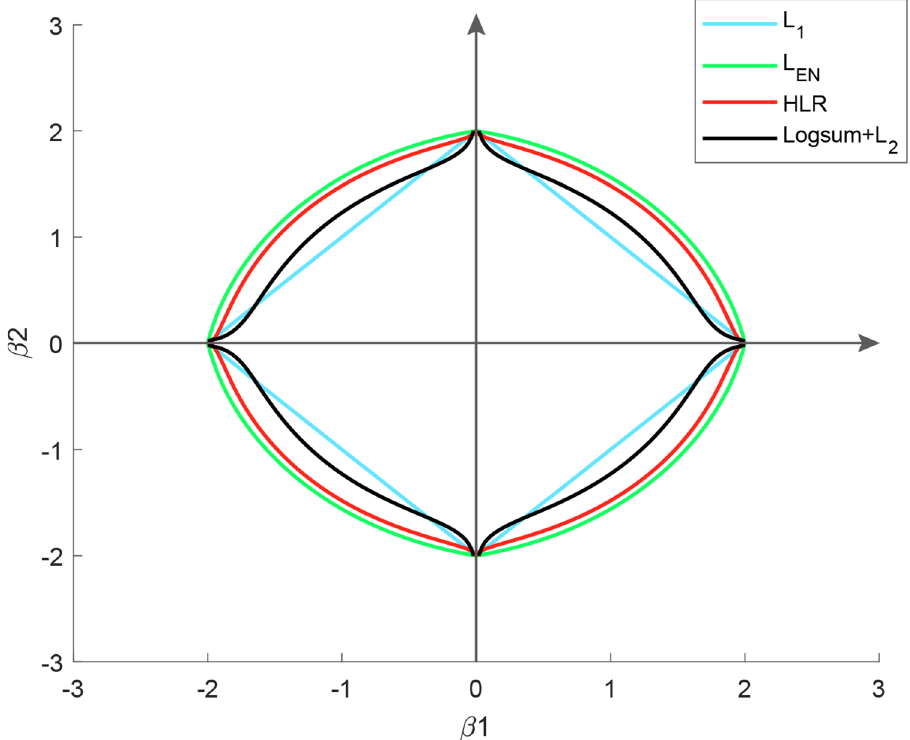
Figure 1. Contour plots (two-dimensional) for the regularization